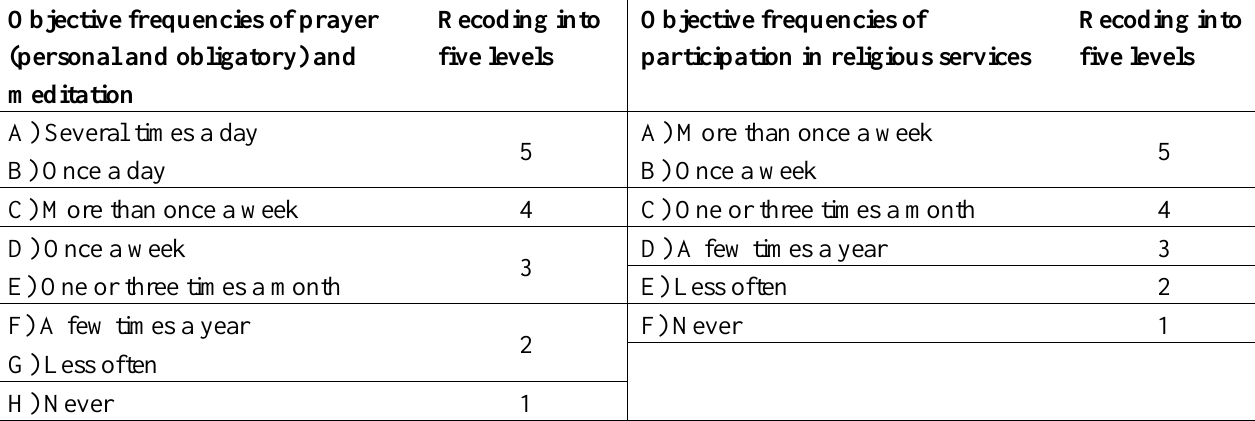
Table 3. Recoding of objective frequencies of the items concerning prayer, meditation, and religious services into five score levels.